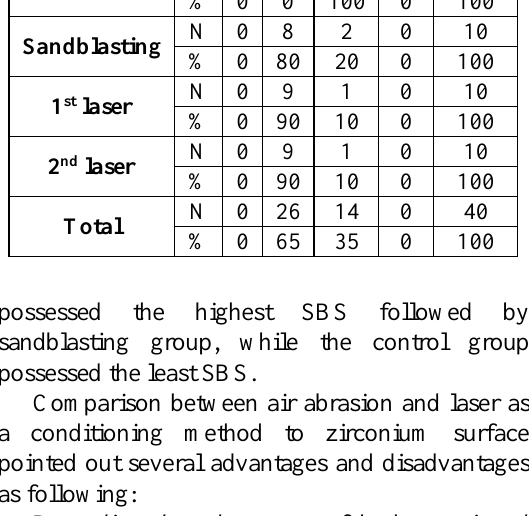
Table 3: Frequency distribution of the ARI scores in different groups